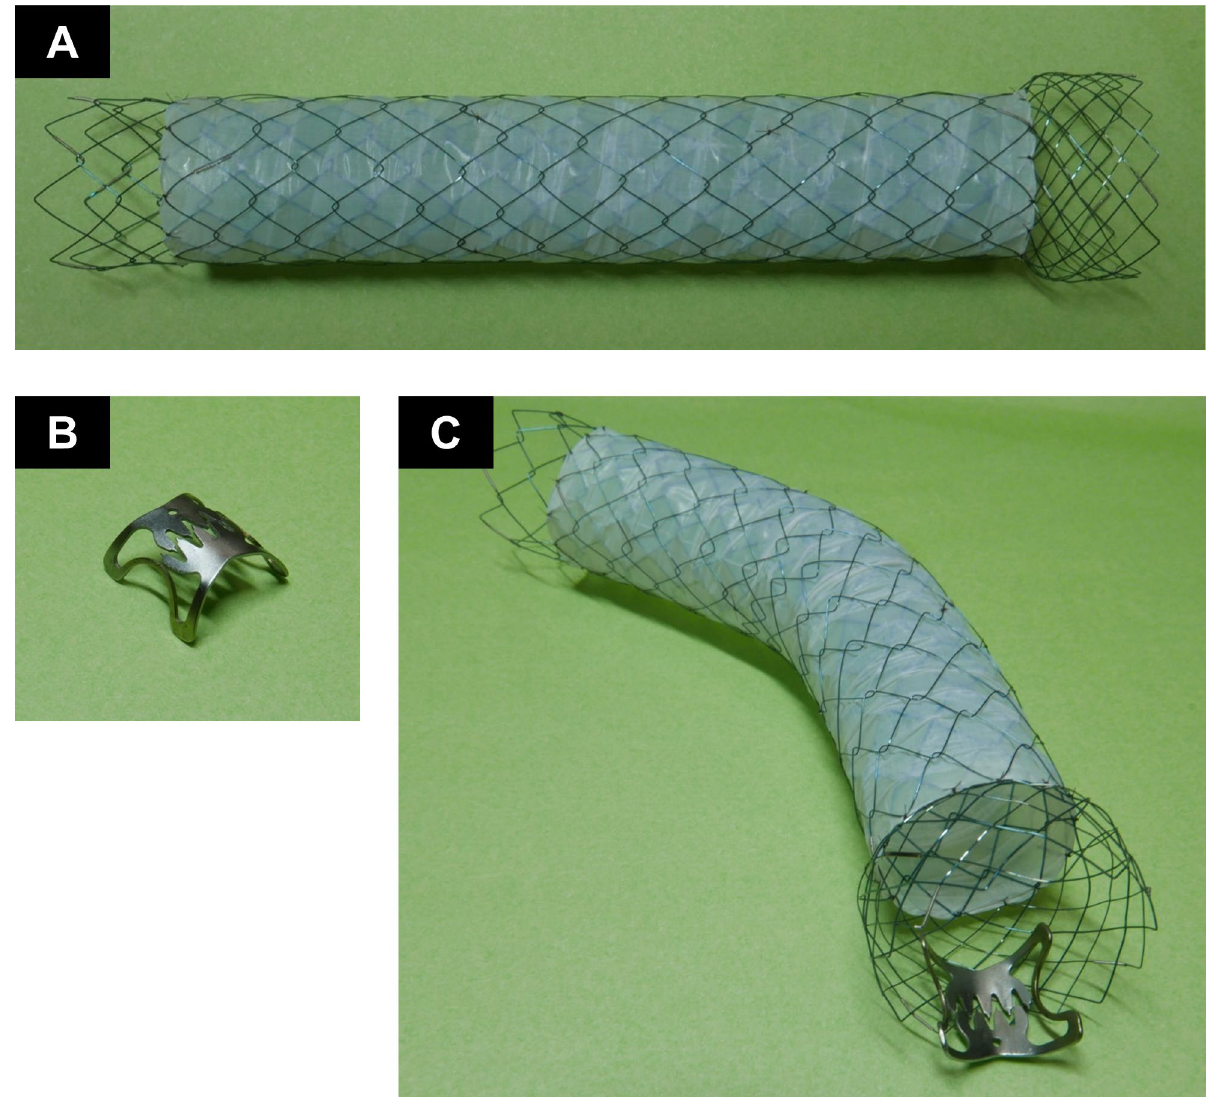
Figure 2. Devices and ex vivo image of this study. ( A ) The partially covered self-expandable metal stent (PC-SEMS) is 20 mm in diameter and 120 mm in length, with an uncovered flare (15 mm in length) at both ends. The proximal flare was 25 mm in diameter. ( B ) Over-the-scope-clip (OTSC). ( C ) Ex vivo image of duodenal PC-SEMS fixation. An OTSC is attached to the proximal flare of the PC-SEMS placed in the gastrointestinal